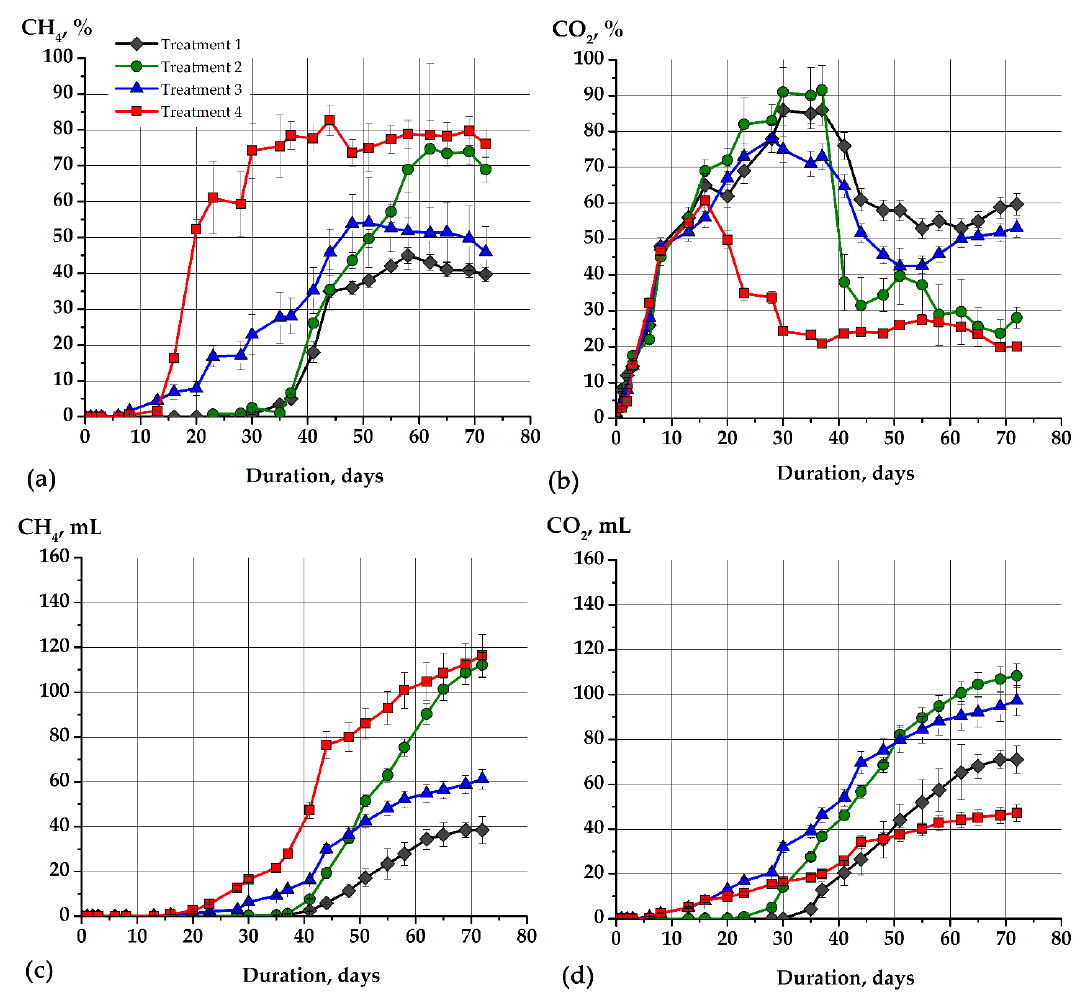
Figure 3. The production of biogas from sodium acetate and the model soapstock during microbial purification: concentration of CH 4 ( a ), concentration of CO 2 ( b ), cumulative production of CH 4 ( c ), cumulative production of CO 2 ( d ). The figure shows the dynamics of biogas production in different variants with sodium acetate and non-adapted methanogens (gray lines, treatment 1), sodium ace- tate with adapted methanogens (green lines, treatment 2), model soapstock as a substrate and non- adapted methanogens (blue lines, treatment 3), model soapstock as a substrate and adapted meth- anogens (red lines, treatment 4).